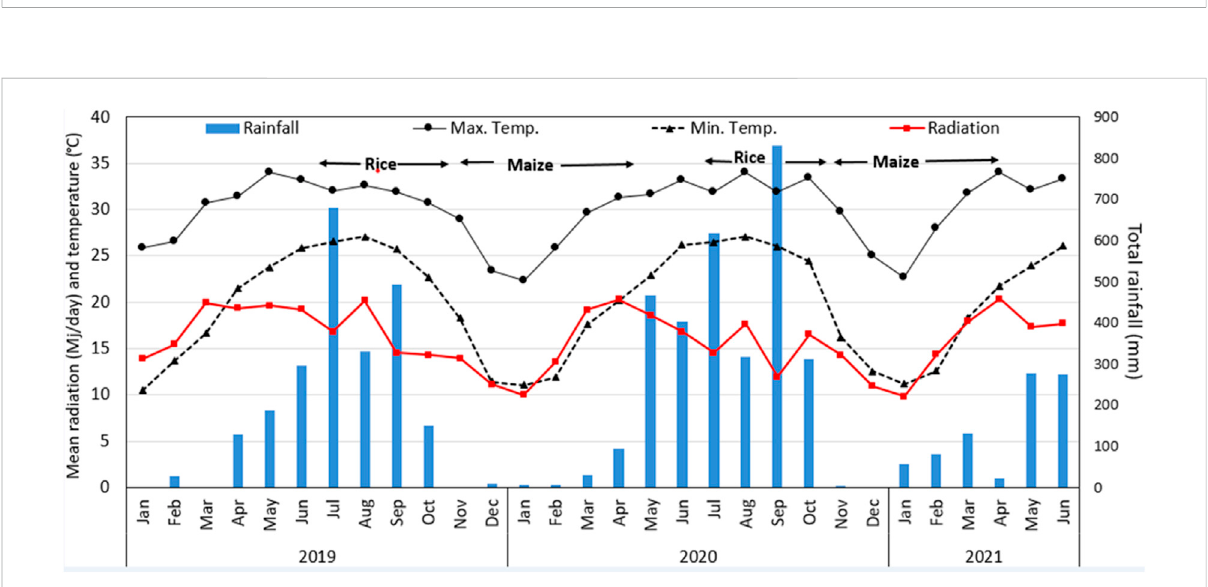
FIGURE 2 Observed rainfall, solar radiation, and maximum and minimum temperatures in the study